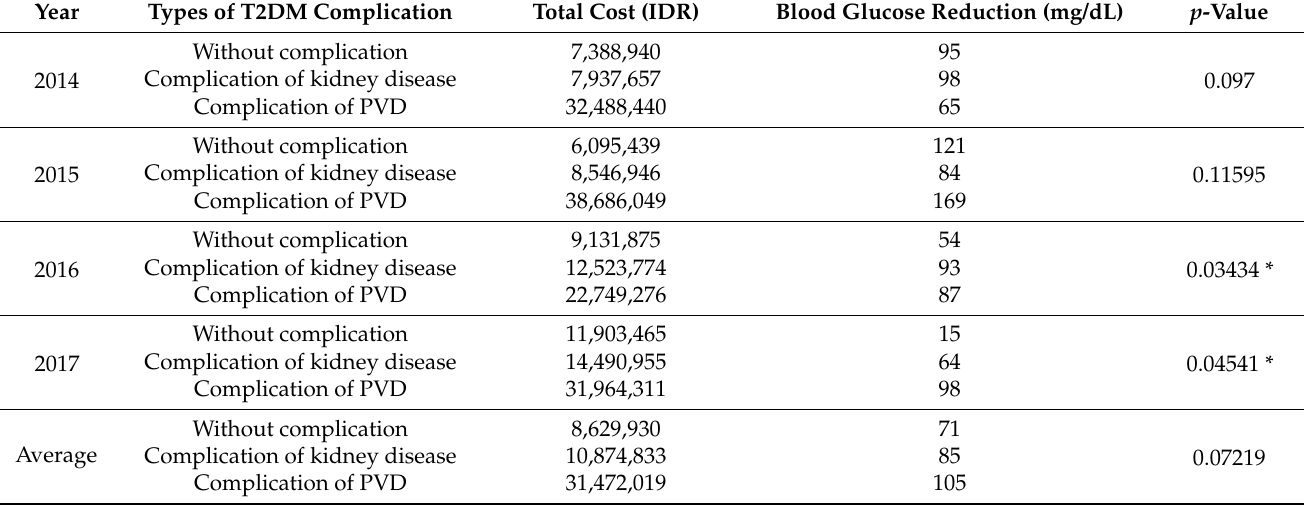
Table 5. Cost-effectiveness value from the perspective of healthcare